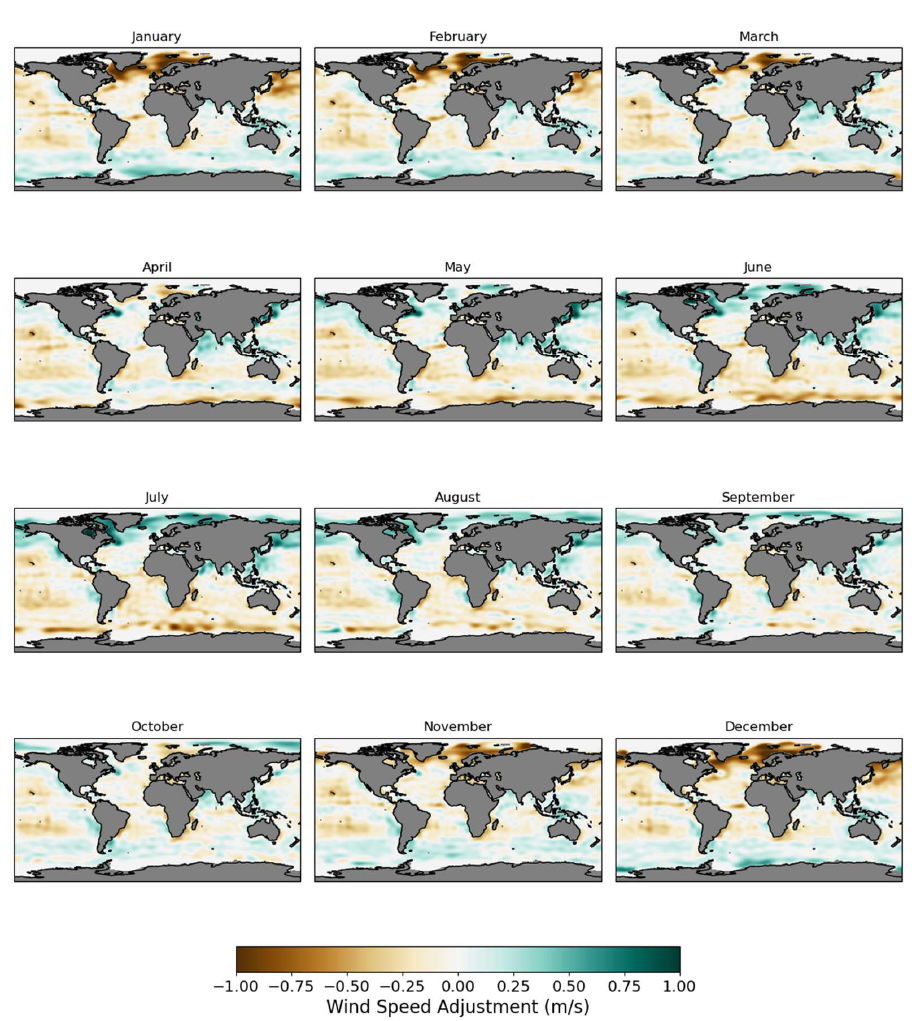
Figure A7. Wind Speed Adjustments applied to RAD_LO winds before inclusion in CCMP.